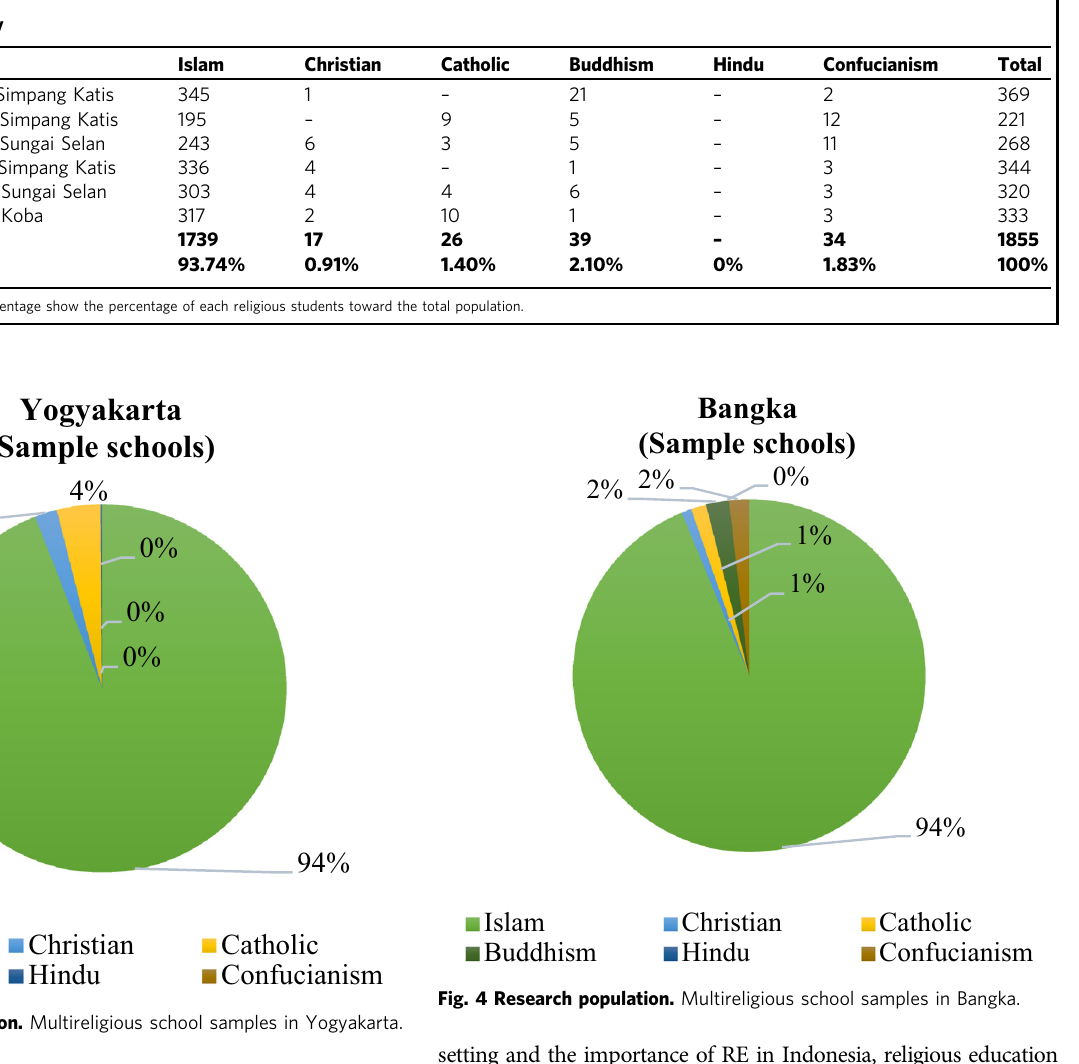
Table 3 Demographic information of students ’ religion on sample schools in Central Bangka regency, Bangka.